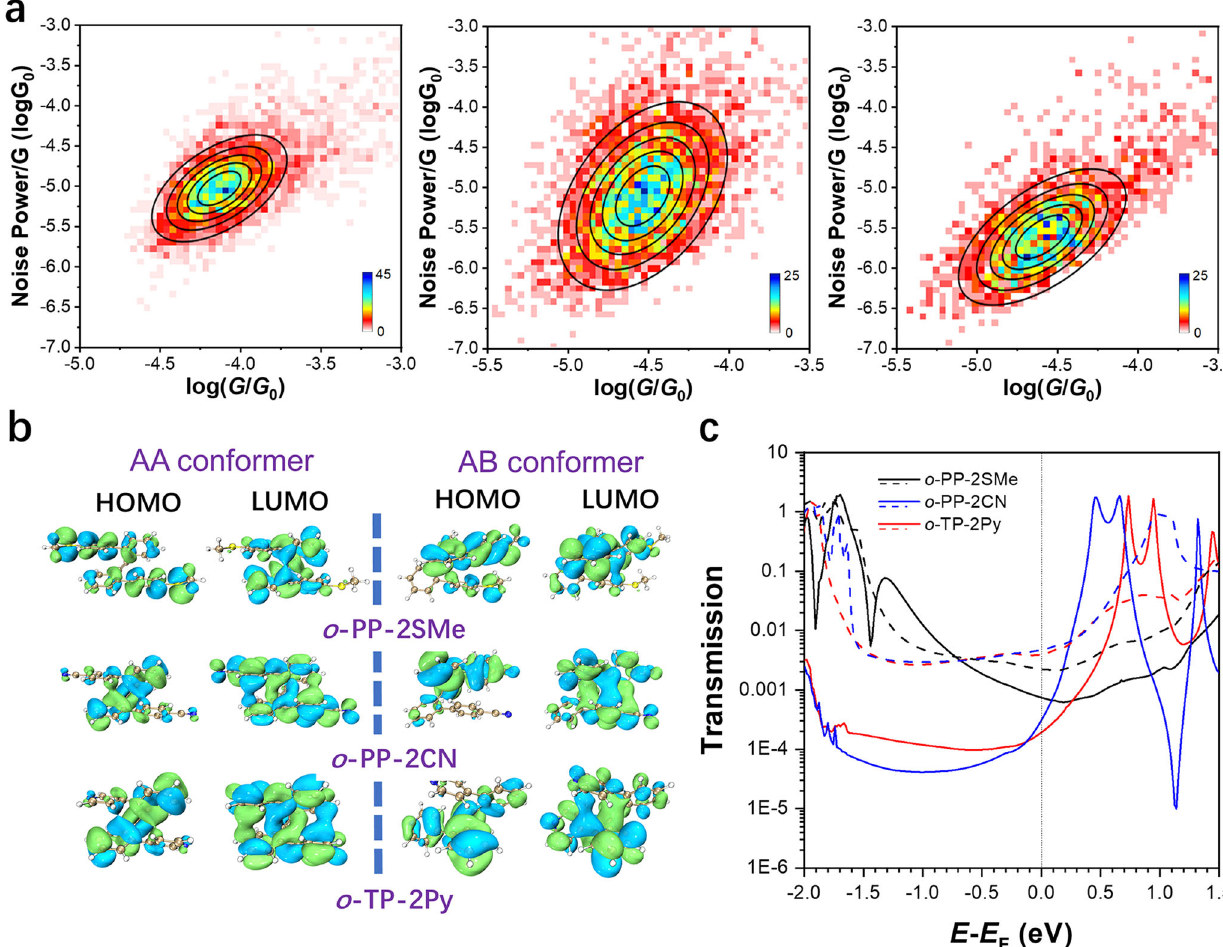
Fig. 6 The analyses of multichannel conductance of o -PP derivatives based on fl icker noise analyses and theoretical calculation. a The two-dimensional histograms of normalized noise power versus average conductance for o -PP-2SMe, o -PP-2CN, and o -TP-2Py. b Calculated highest occupied molecular orbitals (HOMOs) and lowest unoccupied molecular orbitals (LUMOs) for o -PP-2SMe, o -PP-2CN, and o -TP-2Py in AA and AB conformers. c Transmission spectra for o -PP-2SMe, o -PP-2CN, and o -TP-2Py in AA and AB conformers. The solid lines in transmission spectra correspond to AA conformers and the dash lines correspond to AB